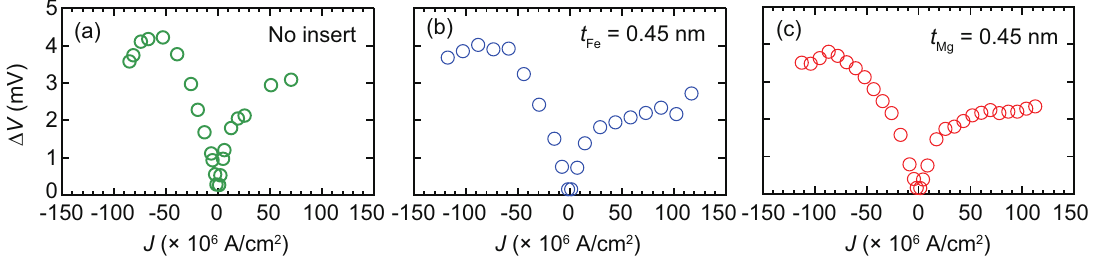
Figure 5. Bias current density, J , dependence of the output voltage, ∆ V for the junctions with ( a ) no insert; ( b ) Fe inserts, and ( c ) Mg inserts. The thickness of the inserts is 0.45 nm for ( b , c